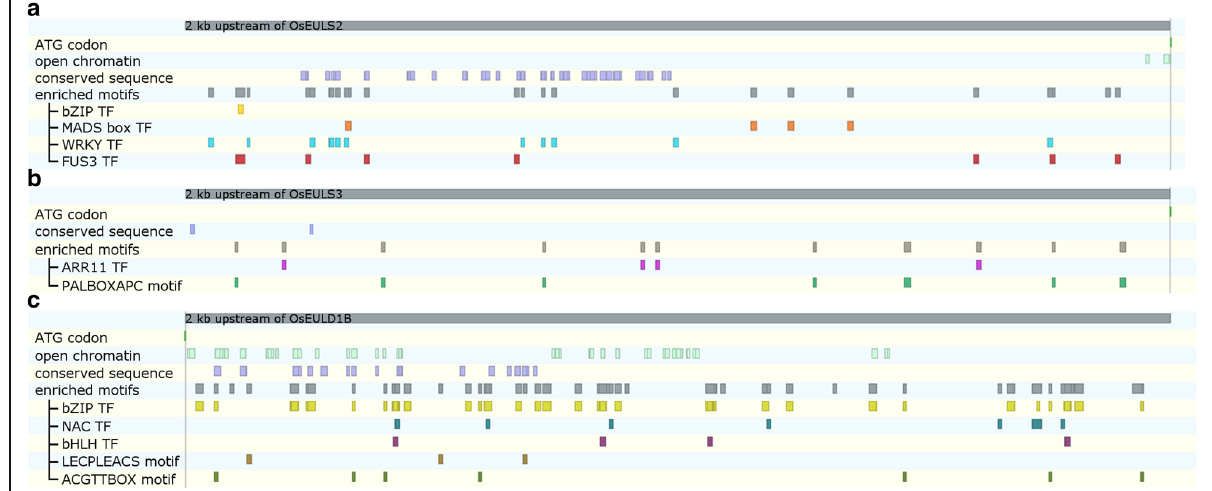
Fig. 6 Cis-regulatory elements in the EUL promoter sequences. Elements identified in the OsEULS2 ( a ), OsEULS3 ( b ) and OsEULD1B ( c ) promoter by the different analyses performed in the integrated approach: motifs in open chromatin, motifs in conserved sequences and motifs enriched in OsEUL regulons. The motifs enriched in the OsEUL regulons are annotated according to the associated transcription factor or motif name. Gray bars represent the 2.000 bp upstream from the ATG codon of the different